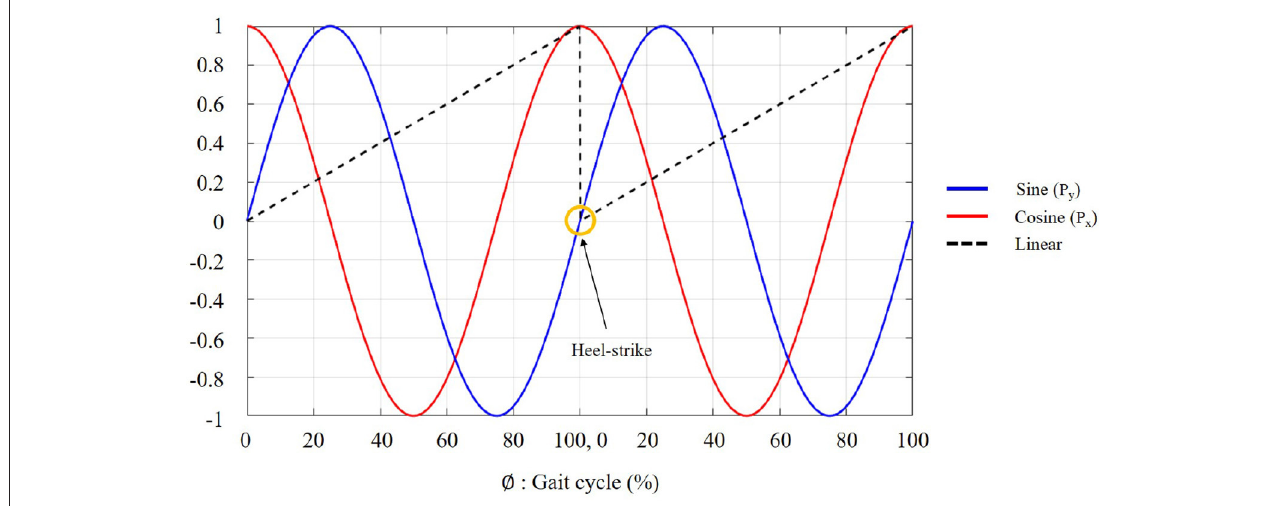
FIGURE 1 | Ground truth labeling. Sine (Blue) and cosine (Red) functions are transformed into a bounded linear function (Black) . Gait initiation occurs at the heel-strike.